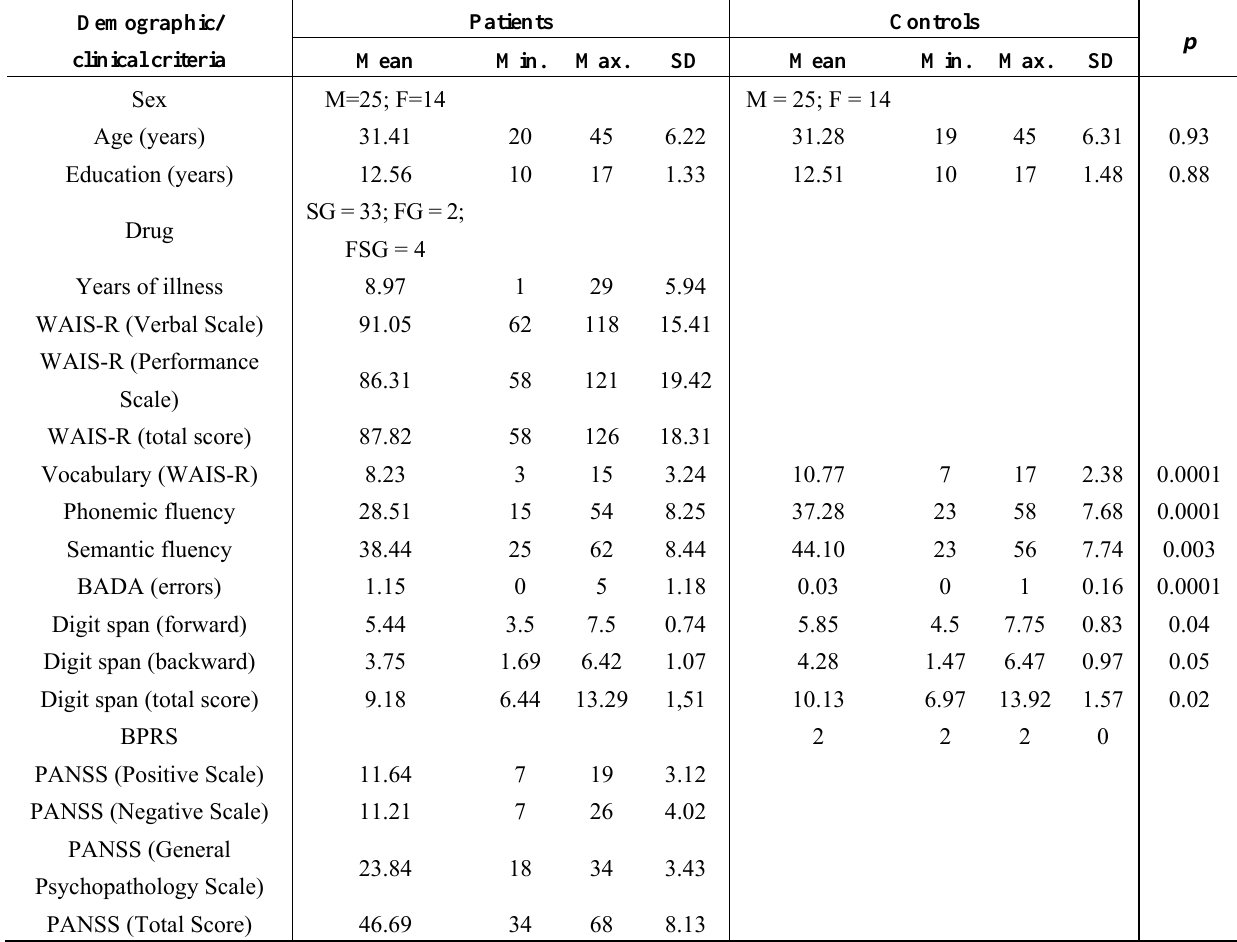
M = male; F = female; FG = first-generation antipsychotics; SG = second-generation antipsychotics; FSG = combination of first- and second-generation